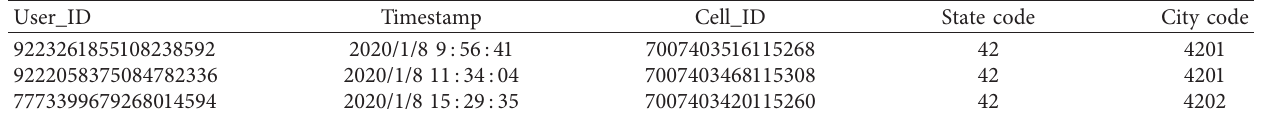
Table 1: An example of CDR and VLR dataset attributes.